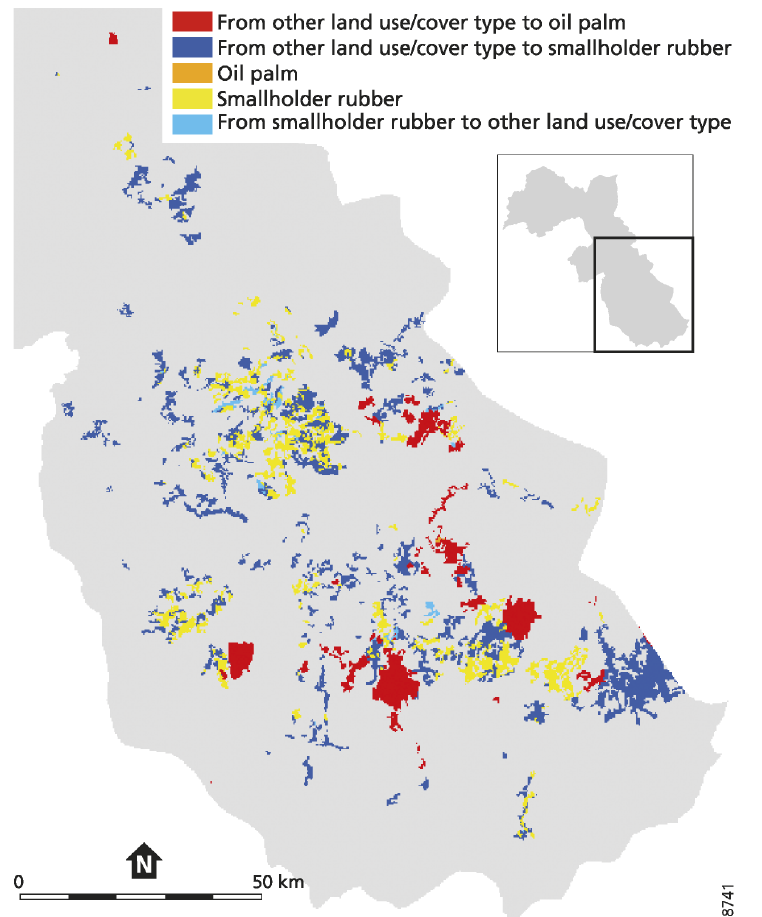
Figure 5. Land cover change trajectories related to smallholder rubber and oil palm mapped for the period 1990–2009 (one raster cell is 100 m × 100